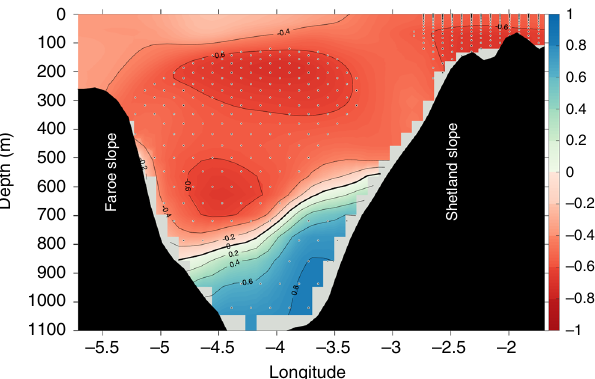
Fig. 7 Enhanced deep jet coincide with increased over fl ow density. Longitude-depth correlation pattern between annual mean Faroe – Shetland Channel jet (FSCJ) volume transport and density variations across the Faroe – Shetland Channel (FSC) (Supplementary Fig. 1, inset) for the 1990 – 2010 period. Positive correlation means that a stronger FSCJ coincide with higher over fl ow density. This correlation pattern outlines the structure of the FSCJ, with the maximum correlation located at depth in the eastern boundary of the FSC. Stipplings indicate correlations signi fi cant at the 95% con fi dence level according to a random phase test 35 using 20000 Monte Carlo